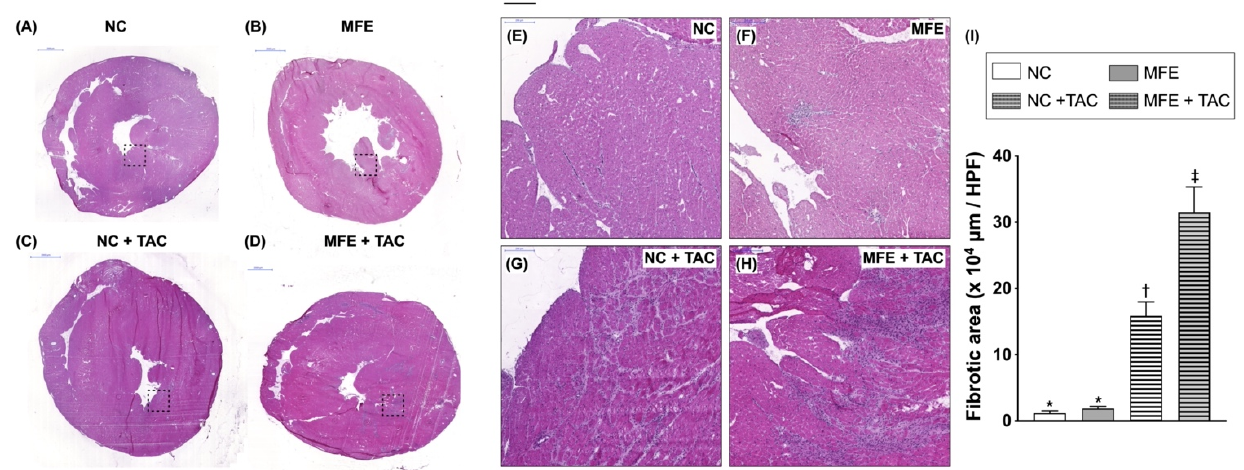
Figure 1. Hematoxylin and eosin (H&E) staining on myocardial sections of offspring with maternal fructose exposure (MFE) and ventricular pressure overload induced by transverse aortic constriction (TAC). ( A , E ) Normal control rat offspring. ( B , F ) Rat offspring with MFE. ( C , G ) Normal control rat offspring with TAC. ( D , H ) Rat offspring with MFE and TAC. ( I ) Comparison of myocardial infarcted areas among different treatment groups. ( E – H ) Enlarged image from the area within dotted rectangles in ( A – D ). NC, normal control. Groups with different symbols (*, †, ‡), p < 0.05. n = 8 for each group. Scale bars in left upper corner of ( A – D ) and ( E – H ) indicate 2000 and 200 µm, respectively.